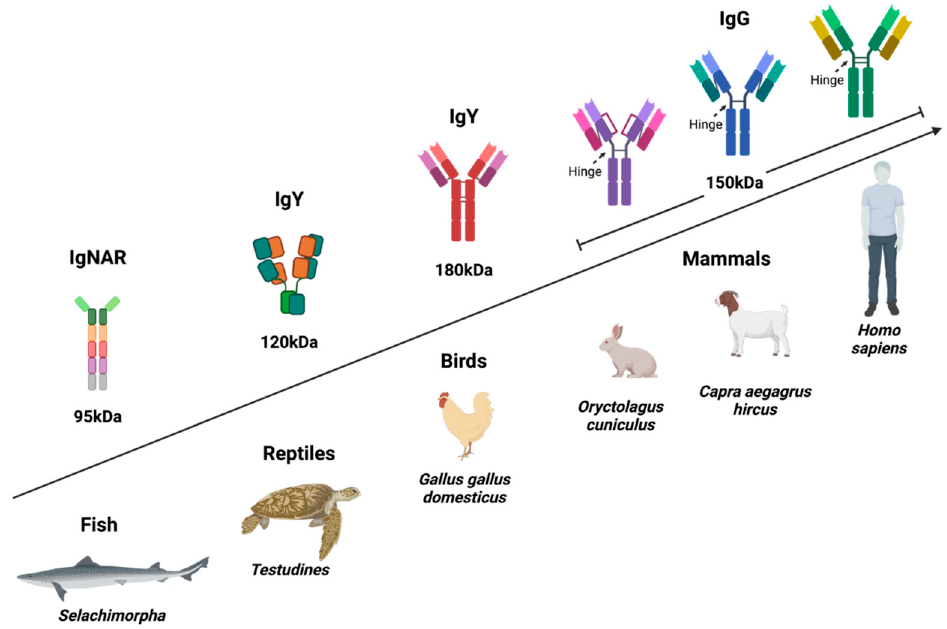
Figure 2. Structure of IgY compared to the IgG of different species. Avian IgY differs from mammalian IgG in that it has four constant domains and lacks a hinge region, which gives it high specificity. The Fc of IgY presents greater resistance to proteolytic degradation, does not bind to rheumatoid factor, and does not activate the human complement. Some reports suggest that IgY can increase the phagocytosis of specific pathogens, which could favor their elimination, but it is also possible that it promotes the infection of cells involved in the immune response, favoring their maintenance [13]. Therefore, more clinical studies are required to validate the safety and effectiveness of IgY in humans. Created with BioRender.com (accessed on 8 August 2022).